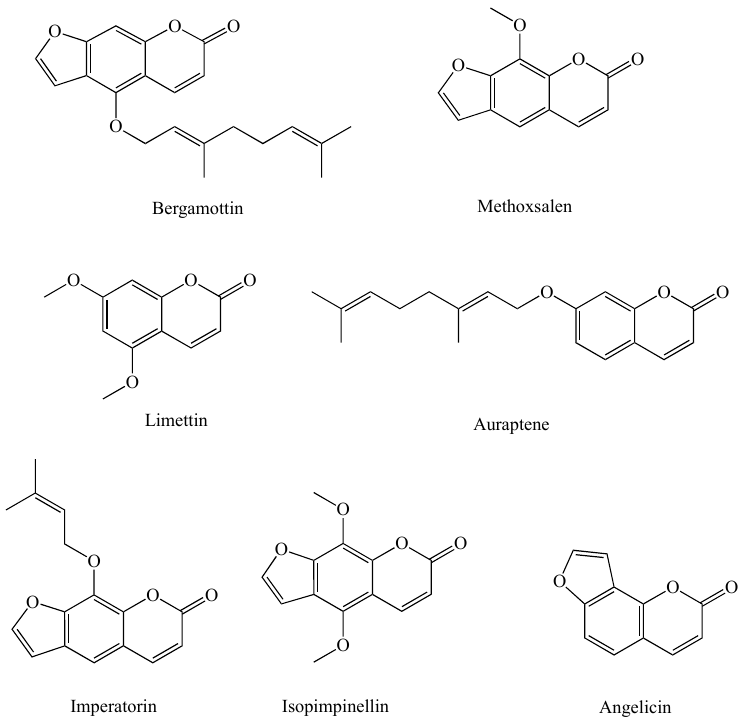
Figure 3. Sample coumarin P450 substrates and inhibitors.